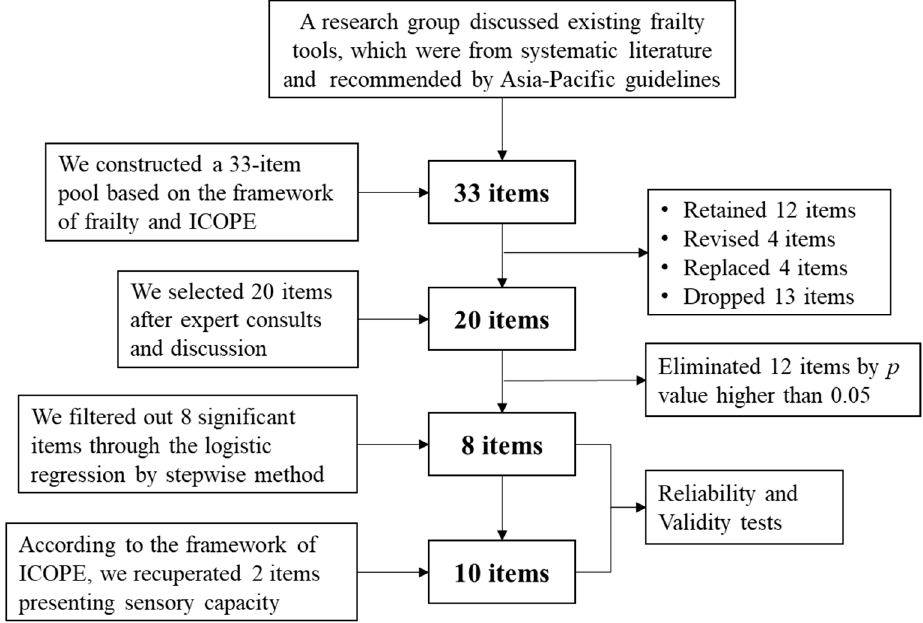
Figure 1. Flow chart of the 10-item Chinese frailty screening scale (CFSS-10)